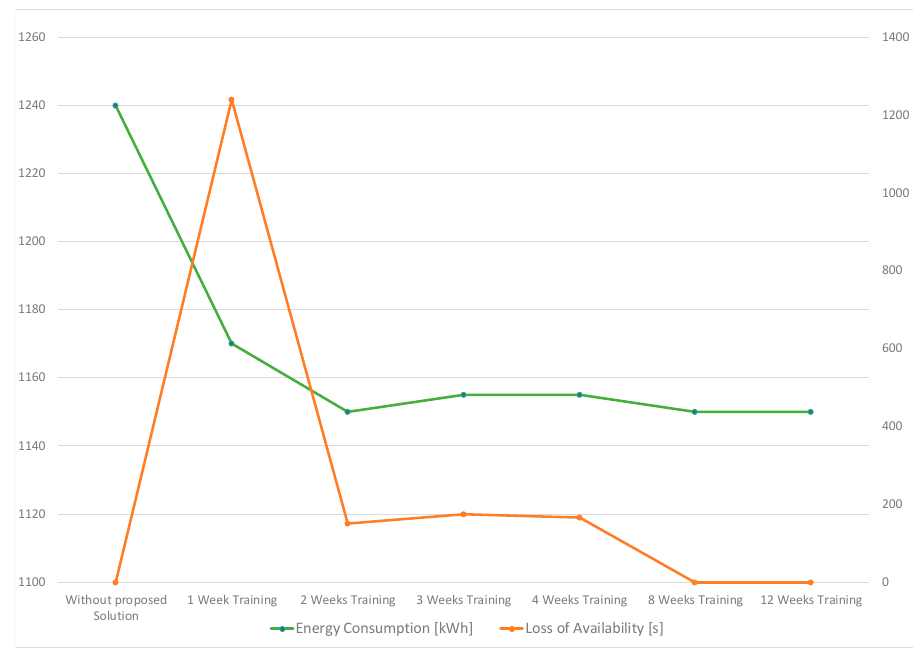
Figure 8. Energy saving result and machine availability.